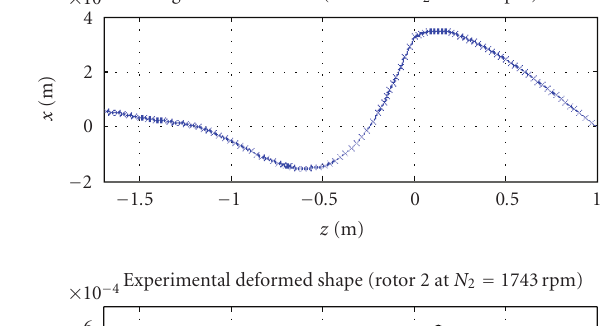
(b) Deformed shapes for mode 1 (forward, rotor 2)